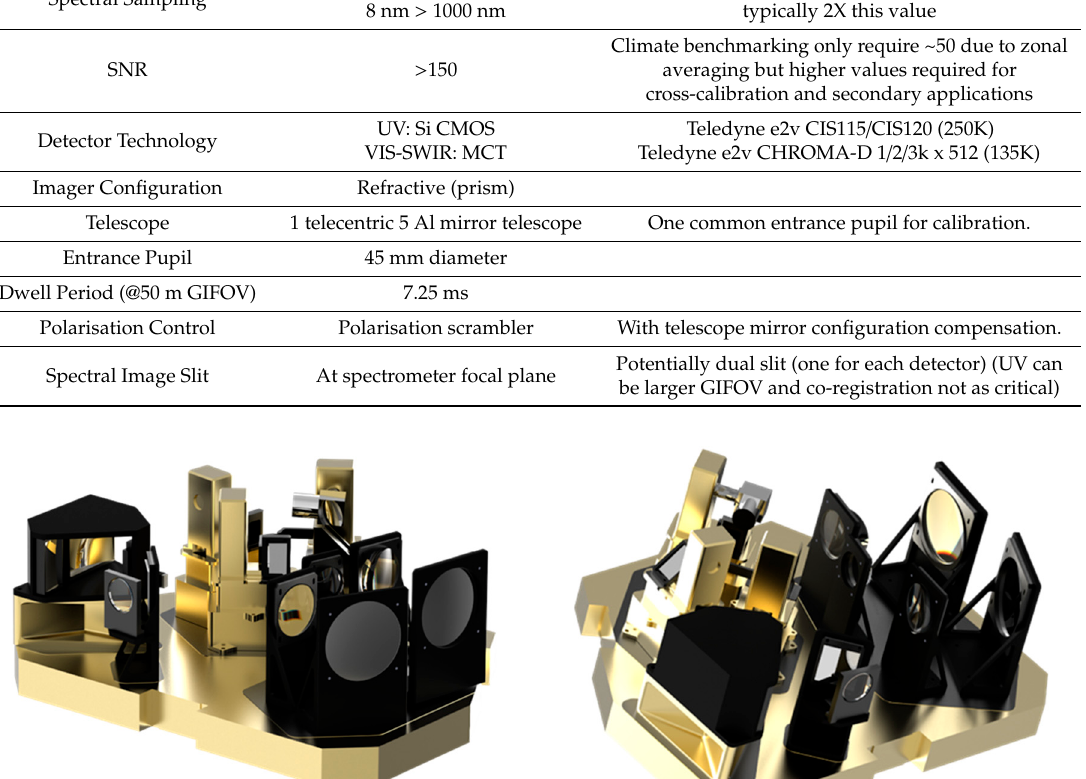
Table 8. Indicative hyperspectral imaging spectrometer (HIS) specifications based on an indicative implementation.